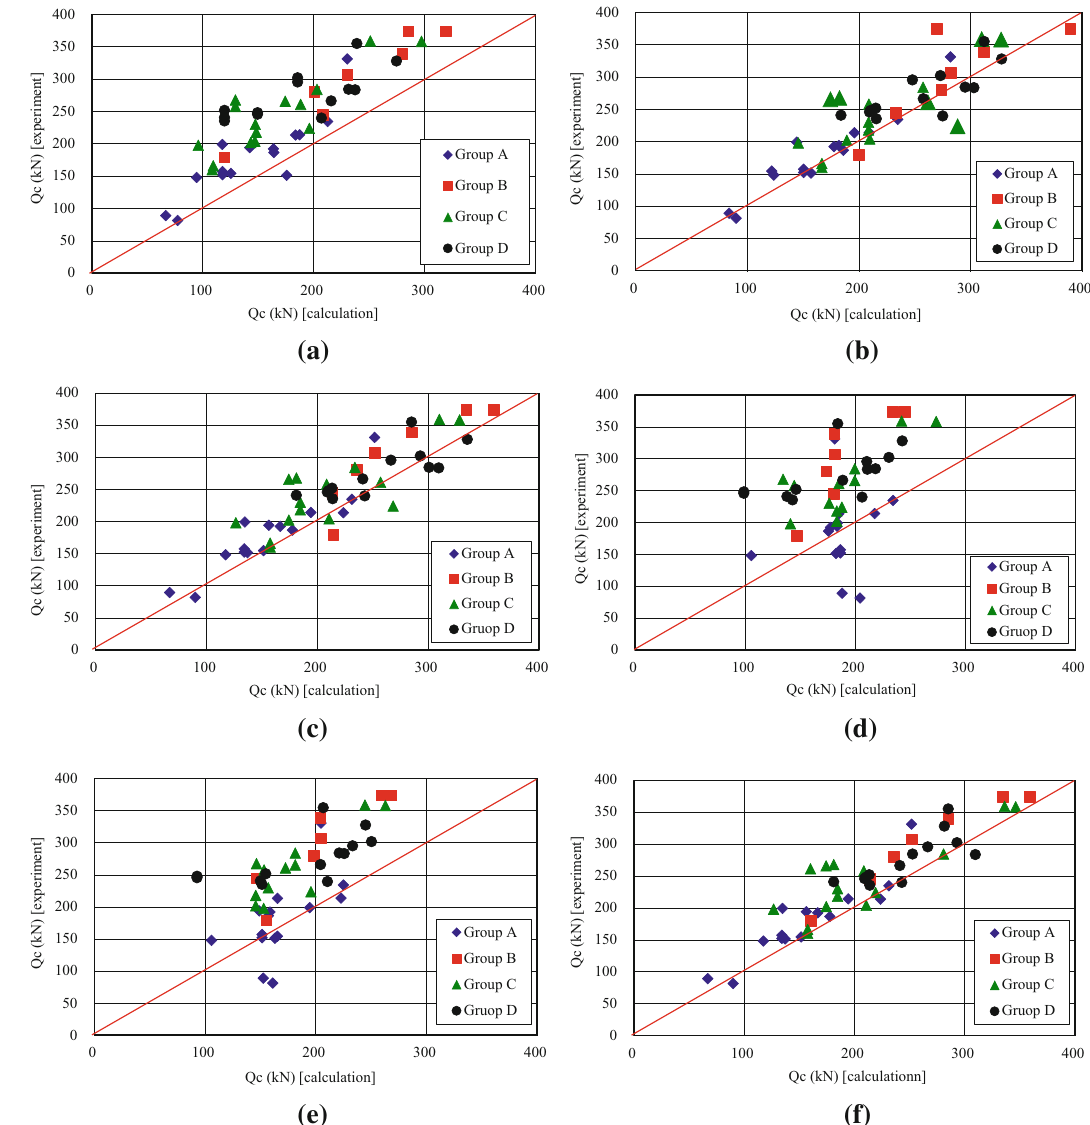
Fig. 5 Comparing equations with test results: a American Society of Civil Engineers (ASCE) equation, b Kanno equation, c M- Kanno equation, d Architectural Institute of Japan (AIJ) equation, e M-AIJ equation, and f our proposed